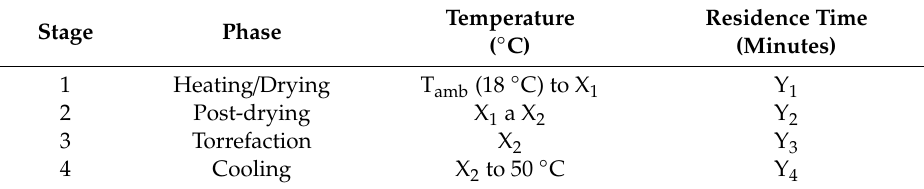
Table 1. Correlation of the levels and the torrefaction phases.